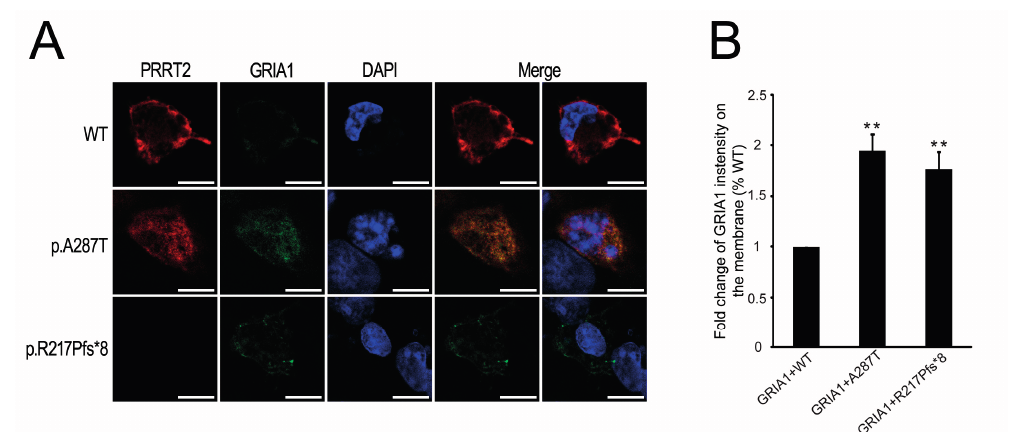
Figure 5. ( A ) PRRT2 limits membrane distribution of GRIA1. The first row shows Flag-tagged wild type PRRT2 (red), live-labeling of the surface HA-tagged GRIA1 (green). The second row shows Flag-tagged p.A287T mutant form of PRRT2 (red), live-labeling of the surface HA-tagged GRIA1 (green). The last row shows Flag-tagged p.R217Pfs*8 mutant form of PRRT2 (red), live-labeling of the surface HA-tagged GRIA1 (green). Scale bar, 10 μ m. DAPI (blue) was used to show nuclei; ( B ) Histogram shows the fold change of membrane GRIA1 intensity. Values are represented as mean ± SD, n = 10, ** p <